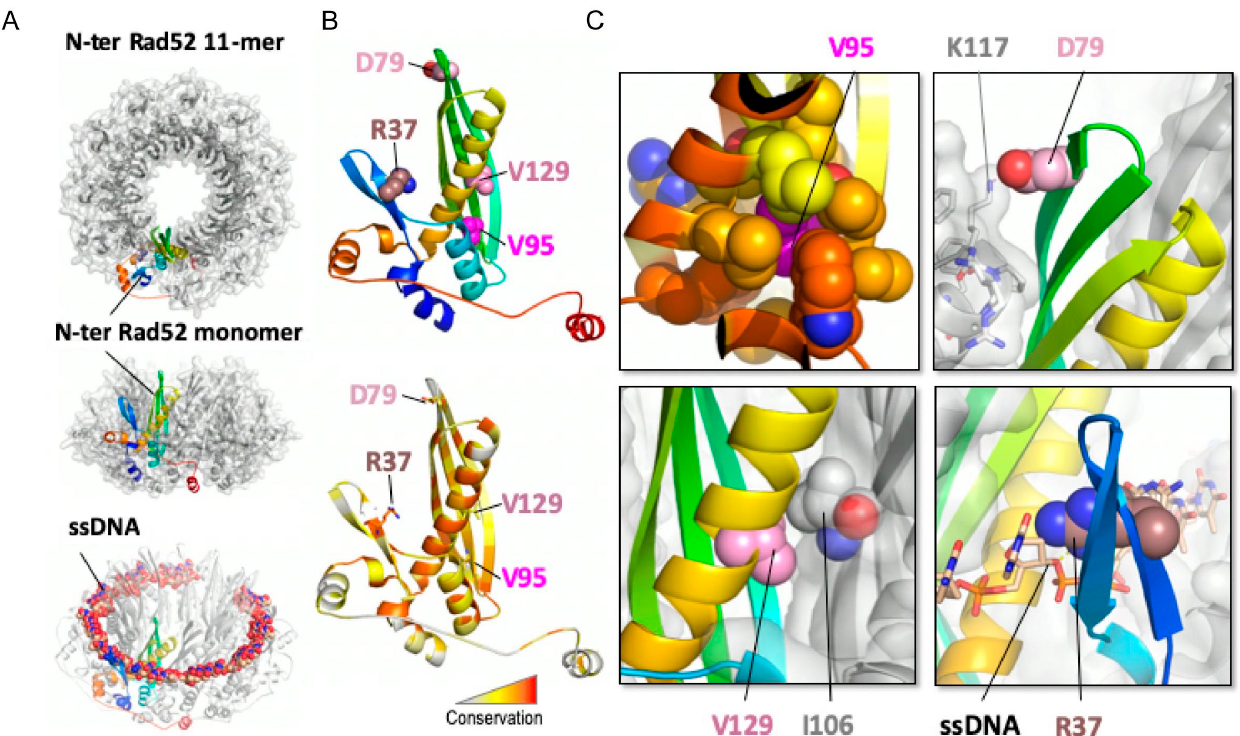
Figure 2. ( A ) Structural representation of the model of S. cerevisiae Rad52 assembled as a 11-mer using the structure of the human homolog bound to ssDNA as template. One subunit is represented as a rainbow cartoon while the other ten subunits are shown as light grey cartoons and transparent molecular surface. ( B ) Cartoon representation of a Rad52 monomer colored in the top panel from N- (blue) to C-terminus (red) and in the lower panel in function of the residue conservation, calculated by the rate4site algorithm with a gradient from white (variable position) to red (conserved position). Residues R37, D79, V95 and V129 are highlighted as pink spheres. ( C ) Four zoomed views centered on each of the four mutated residues highlighting the mutated residue as a sphere. For V95 (upper left panel), the positions surrounding the V95 sidechain (magenta) are shown as spheres with the color code reporting their conservation, as in B (lower panel). For D79 (upper right panel), located at the interface of two subunits, K117 forms a salt-bridge with D79. V129 (lower left panel) is also at the interface between subunits and is highlighted packing against I106 of a neighboring subunit. R37 (lower right panel) contacts the ssDNA phosphate atoms.